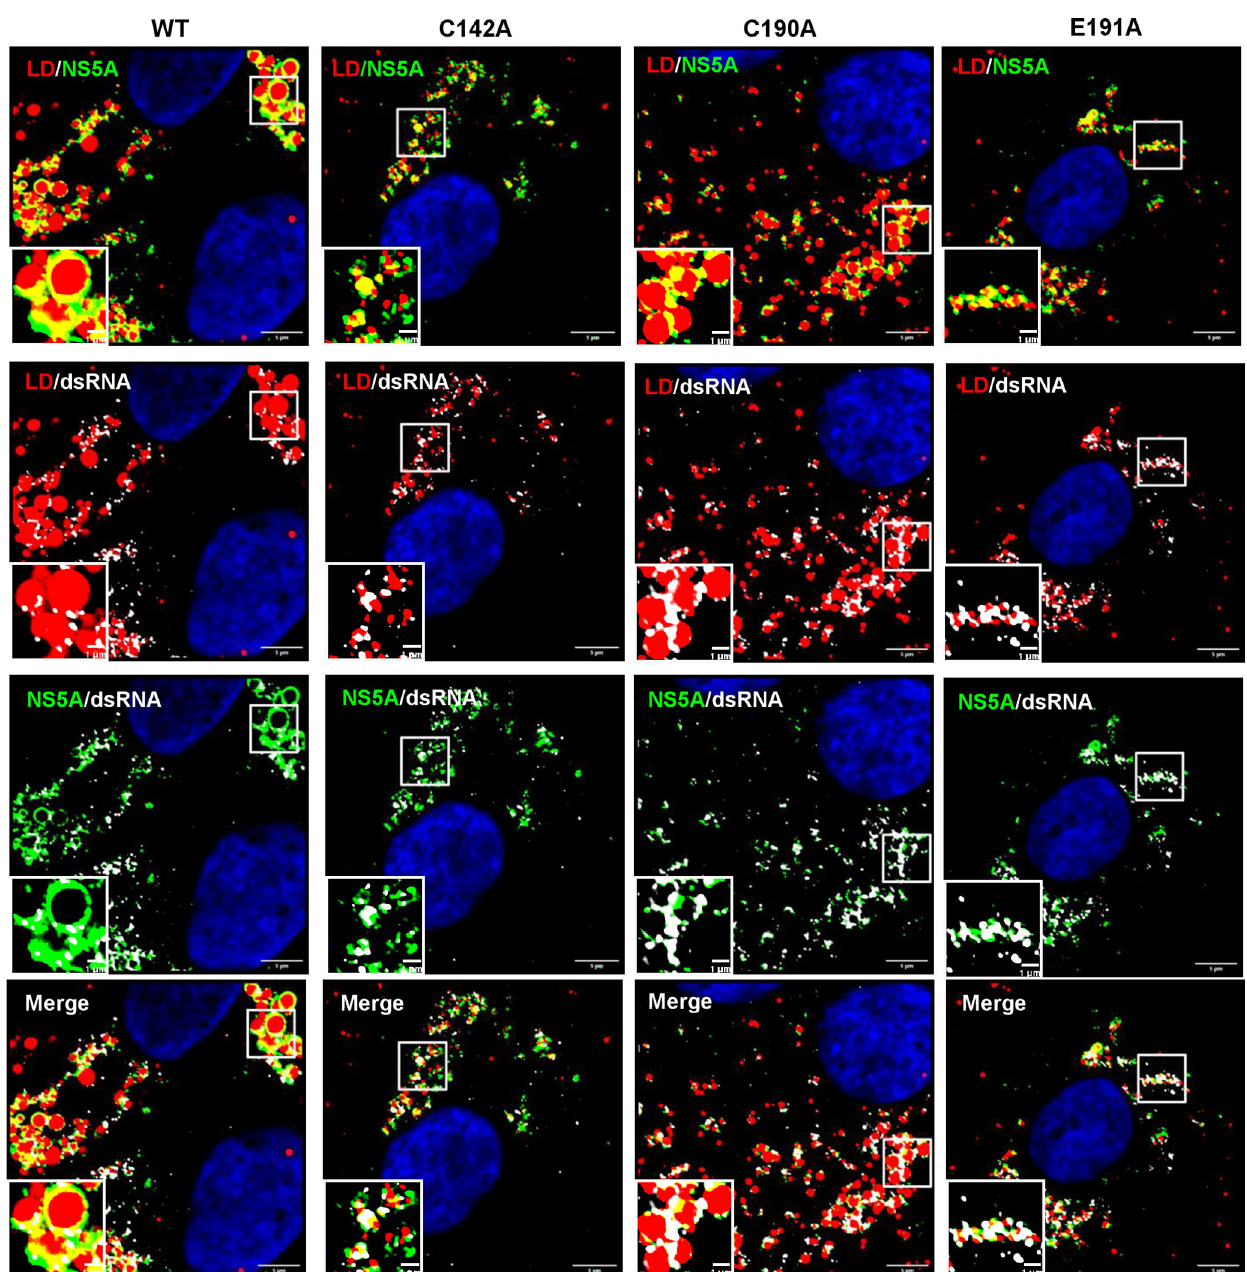
Fig 10. Co-localisation of NS5A, dsRNA and LD. Huh7.5 cells were electroporated with mJFH-1 WT and DI mutant C142A, C190A and E191A RNAs and seeded on to coverslips. At 72 hpe cells were stained with sheep anti-NS5A (green), mouse anti-dsRNA J2 (white), BODIPY 558/568-C12 (red) and DAPI. Co-localisation was observed using Airyscan microscopy. Representative images are shown. Representative images of mock electroporated cells is shown in S6C Fig. Scale bars are 5 μ m and 1 μ m